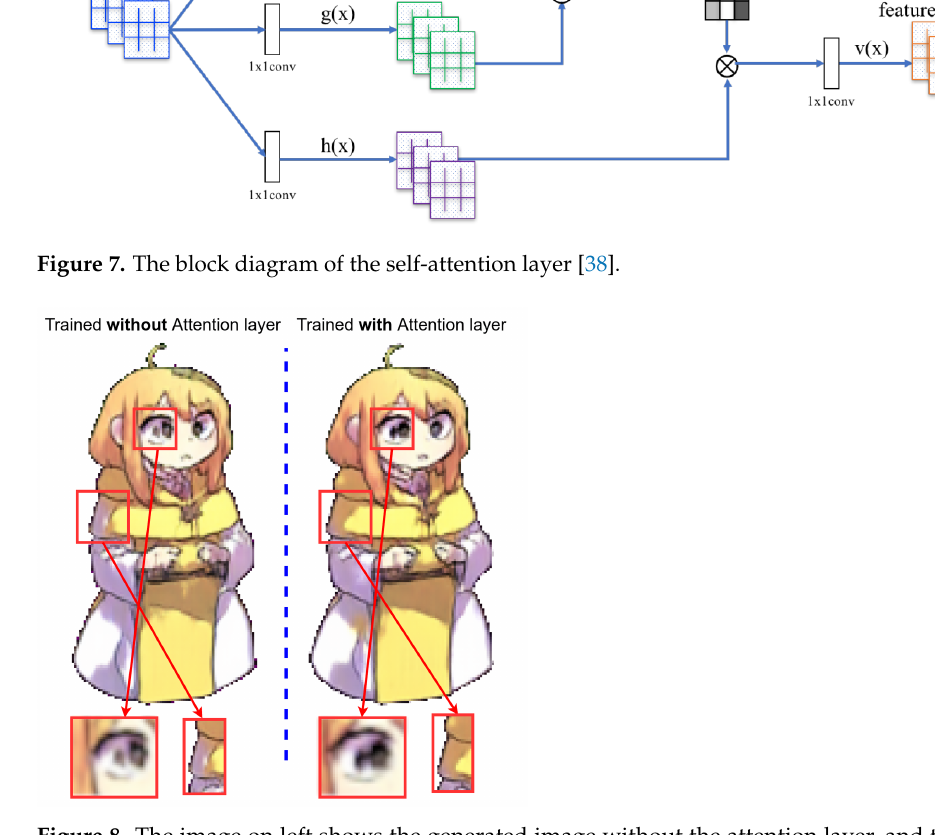
Figure 8. The image on left shows the generated image without the attention layer, and the right shows the generated image with the attention layer. The two images show different qualities of the color distribution on the small